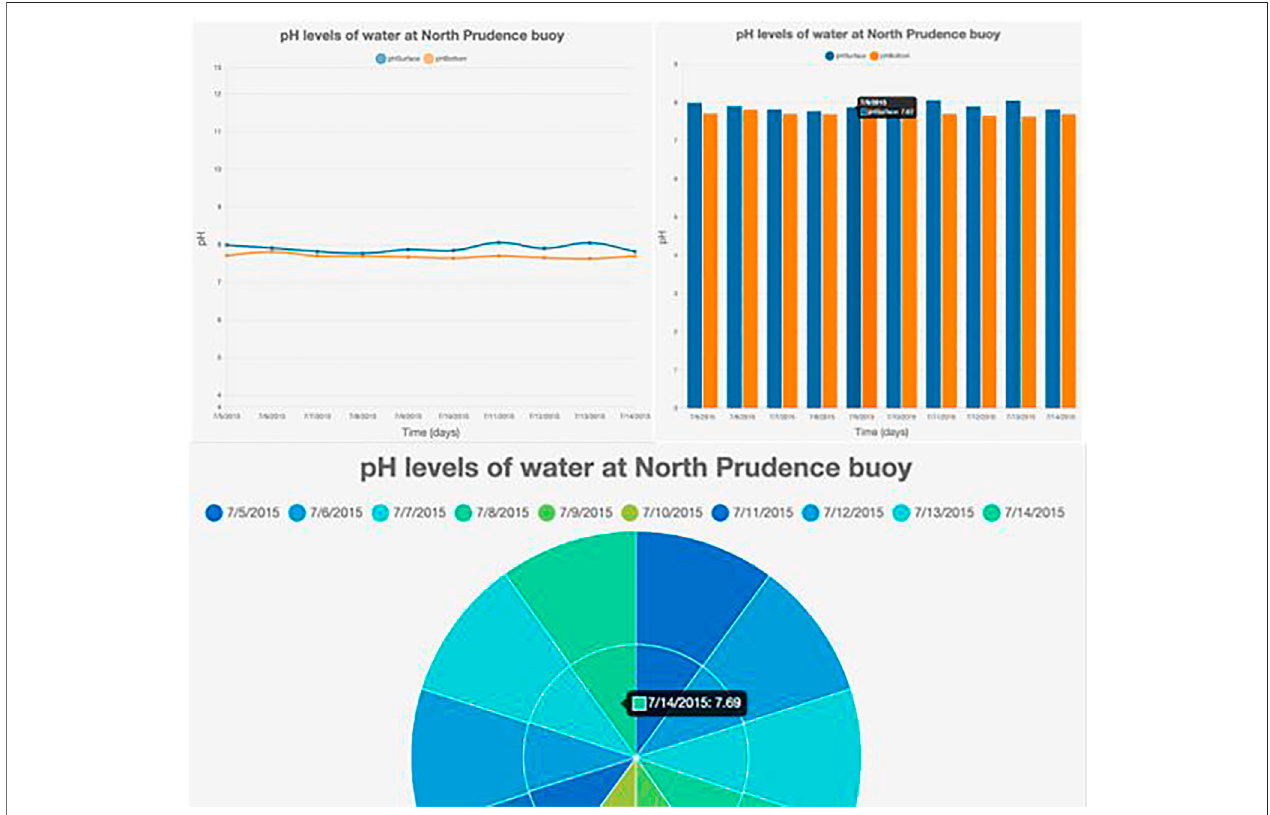
FIGURE 10 | simplechartsri.com creation of line, bar, and pie chart from data table of pH levels by workshop attendees.